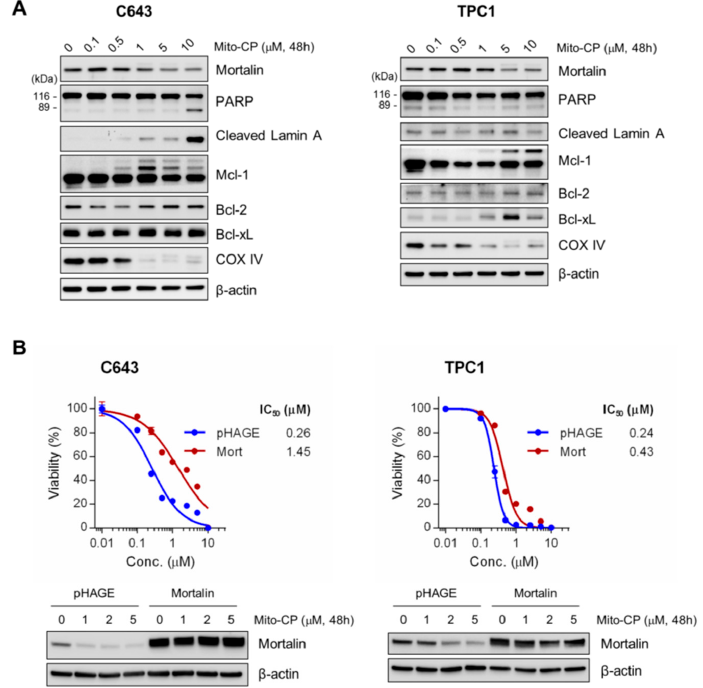
Figure 7. Mito-CP induces mortalin downregulation while mortalin overexpression confers PTC and ATC cells partial resistance to Mito-CP. ( A ) Total lysates of C643 and TPC-1 cells treated with different doses of Mito-CP for 48 h were analyzed by Western blotting for expression of the indicated proteins. β -actin is the control for equal amounts of protein loading. ( B ) C643 and TPC-1 cells infected with lentiviral pHAGE expressing mortalin were treated with serially increasing doses of Mito-CP for 48 h. Cells were then allowed to recover in a drug-free fresh medium for 24 h prior to measuring cell viability by an MTT assay. Data (mean ± SD, n = 4) are expressed as the percentage of untreated control. Western blotting of total cell lysates indicates the degree of mortalin overexpression.